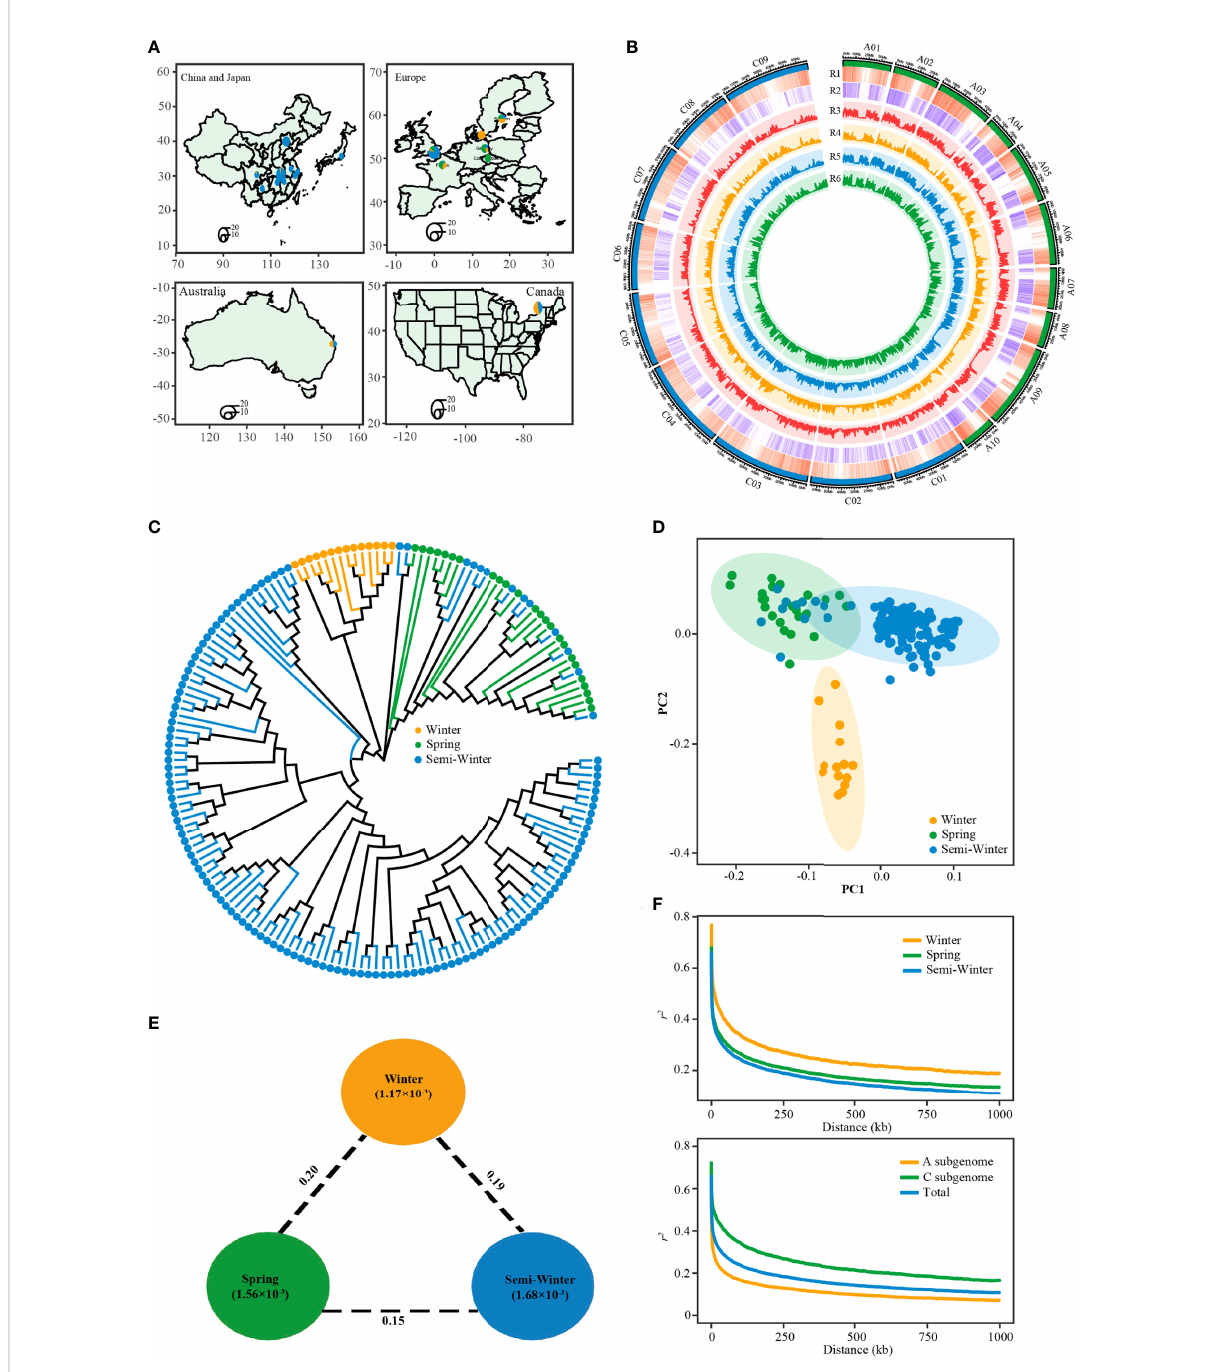
FIGURE 4 Features of the rapeseed population consisted of winter, spring and semi-winter ecotypes. (A) The geographic distribution of the 171 accessions. Accessions from China are represented by a circle on the provincial capital city. Accessions from other countries are represented by a circle on the capital city. Circle size indicates number of accessions. (B) Circos plot showing genetic diversity among three ecotypes. R1: gene density, R2: SNP density, R3: genetic diversity ( p ) in whole population, R4: genetic diversity ( p ) in winter ecotype group, R5: genetic diversity ( p ) in semi- winter ecotype group, R6: genetic diversity ( p ) in spring ecotype group. (C) Phylogenetic tree of all accessions inferred from a subset of 131,319 SNPs, distributed randomly across whole-genome. The yellow, green, and blue dots indicate winter, spring, and semi-winter accessions. (D) PCA plots of the fi rst two components of 171 accessions. (E) Summary of nucleotide diversity and population divergence across the three ecotype groups. Values in circles represent measures of nucleotide diversity for the group, and values between pairs indicate ecotype divergence ( F ST ). (F) Decay of LD ( r 2 ) in the three groups (top) and two subgenomes